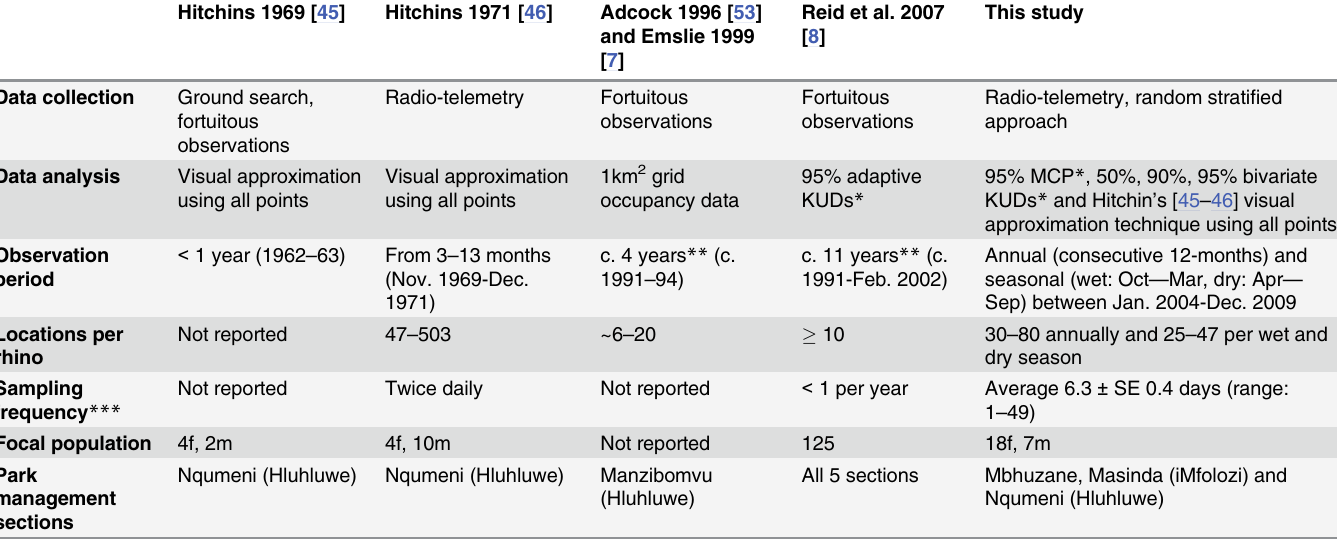
Table 1. Detailed comparison of methodology of home range studies of black rhinoceros Diceros bicornis minor in Hluhluwe-iMfolozi Park, South